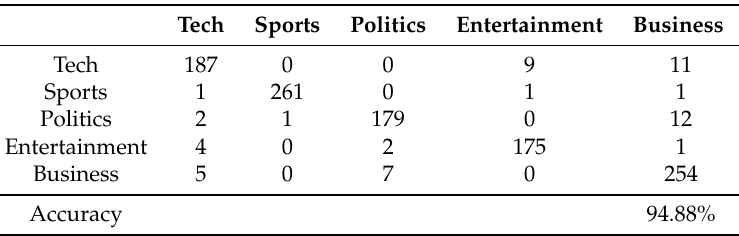
Table 3. Output of the BLSTM-C on the English dataset.